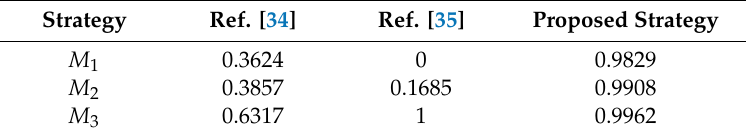
Table 5. Comparison of the evaluation results.